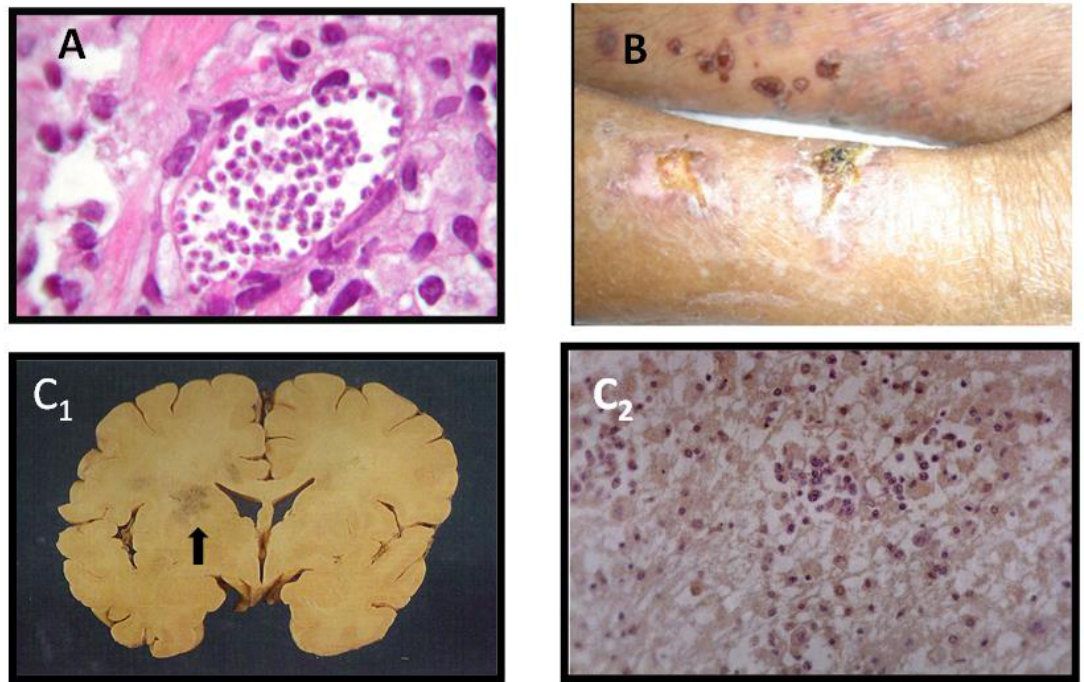
Figure 1. Illustration of Chagas disease reactivation in heart ( A ), skin ( B ), and brain ( C ) in